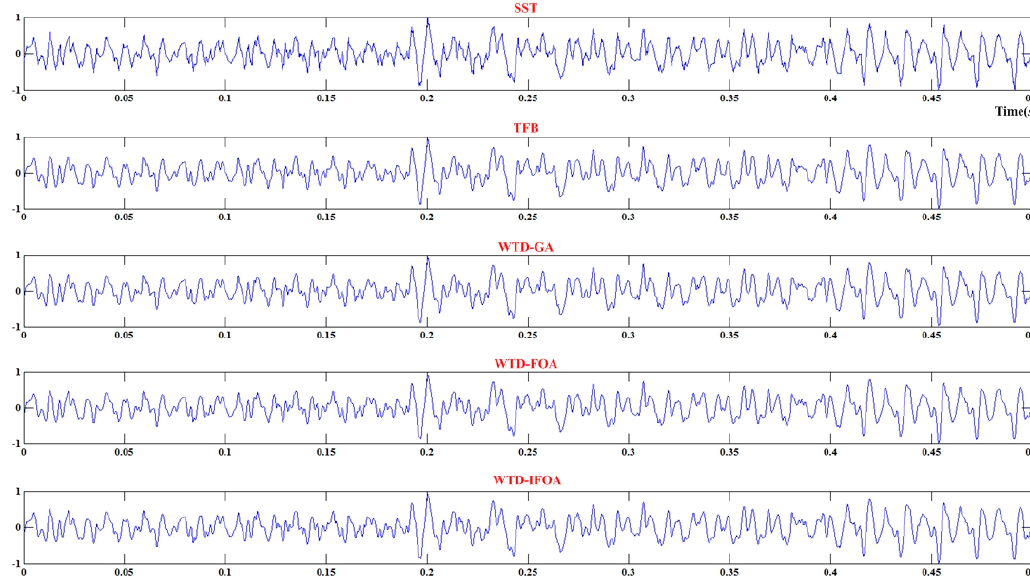
Figure 8. Denoise result of the five methods (SNR = 5 dB).